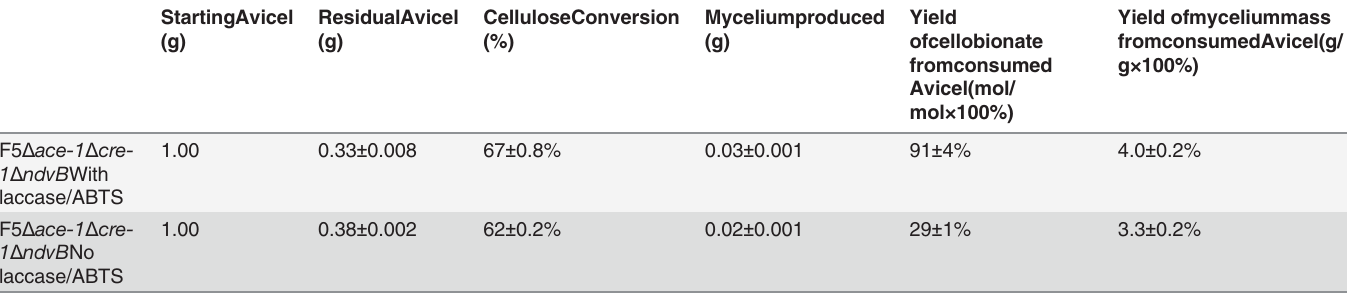
Table 2. Percentage of Avicel hydrolyzed and the percentage directed toward fermentable products for the F5 Δ ace-1 Δ cre-1 Δ ndvB strain grown on 20 g/L Avicel. StartingAvicel (g)